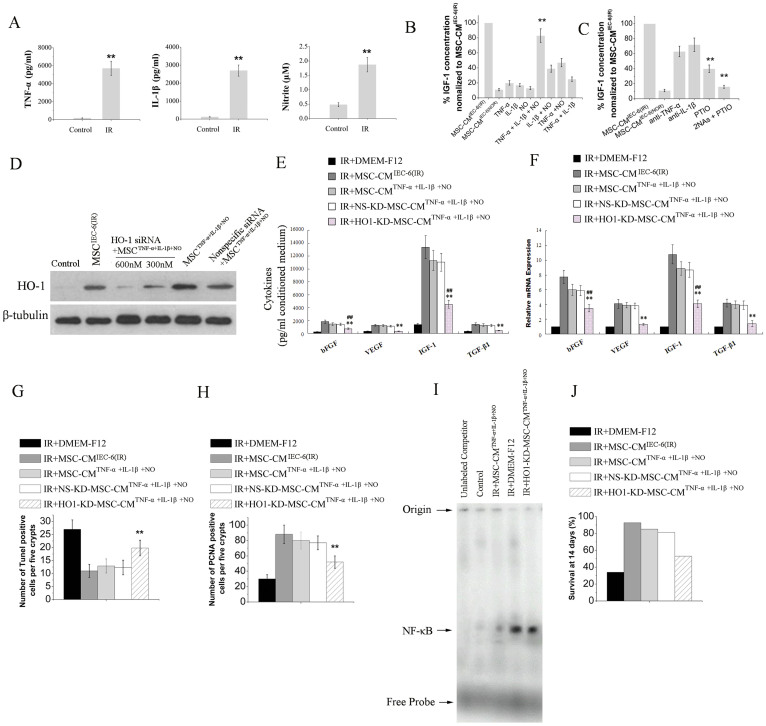
Heme oxygenase-1 mediates the difference in the secretome and the therapeutic effects of MSC-CM with and without pro-inflammatory cytokine stimulation.(A) TNF-α and IL-1β levels were assayed in the cultured medium of MSCs + non-irradiated/irradiated IEC-6 co-cultured system by ELISA. Nitric oxide (NO) in culture medium was assayed by a colorimetric assay for nitrite, a stable byproduct of NO. **, P < 0.05 versus control. (B) MSCs were supplemented with individual recombinant TNF-α (6 ng/ml), IL-1β (3 ng/ml), NO donor (SNP, sodium nitroprusside; 200 μmol/l) or combinations, and the concentration of IGF-1 in conditioned medium was then assessed. **, P > 0.05 versus MSC-CMIR. (C) MSCs + irradiated IEC-6 co-cultured system were supplemented with individual neutralizing antibodies for TNF-α (2 μg/ml), IL-1β (2 μg/ml), NO scavenger (PTIO; 2-phenyl-4,4,5,5-tetramethylimidazoline-1-oxyl-3-oxide; 400 μmol/l) or combinations, and the concentration of IGF-1 in conditioned medium was then assessed. **, P < 0.05 versus MSC-CMIEC-6(IR). MSCs were transfected with varying doses of HO-1 siRNA and nonspecific siRNA prior to TNF-α, IL-1β and NO donor stimulation, the protein levels of HO-1 (D), the secretion (E) and the mRNA expression (F) of IGF-1, bFGF, VEGF and TGF-β1 from MSCs were then detected. **, P < 0.05 versus IR + DMEM-F12, ##, P < 0.05 versus MSC-CMTNF-α + IL-1β + NO. NS-KD-MSC-CMTNF-α + IL-1β + NO, conditioned medium from non-specific siRNA transfected MSCs activated by TNF-α, IL-1β and NO donor. Administration of HO1-KD-MSC-CMTNF-α + IL-1β + NO partially abolished the ability of MSC-CMTNF-α + IL-1β + NO to ameliorated the apoptosis (G) and proliferation (H) of irradiated intestinal epithelial cells which were evaluated by quantification of TUNEL-positive and PCNA-positive cells in histological sections, respectively. **, P < 0.05 versus IR + MSC-CMTNF-α + IL-1β + NO. The DNA-binding activities of NF-κB in nuclear extracts of intestinal tissue (I) were estimated by electrophoretic mobility shift assay (EMSA). The specificity of the DNA/protein was determined by competition reactions in which a 100-fold molar excess of unlabeled NF-κB oligonucleotide (specific competitor). (J) Improved survival of irradiated rats receiving MSC-CMTNF-α + IL-1β + NO (n = 28) was partially reversed in rats (n = 30) receiving HO1-KD-MSC-CMTNF-α + IL-1β + NO (IR + MSC-CMTNF-α + IL-1β + NO
versus IR + HO1-KD-MSC-CMTNF-α + IL-1β + NO: P < 0.05).